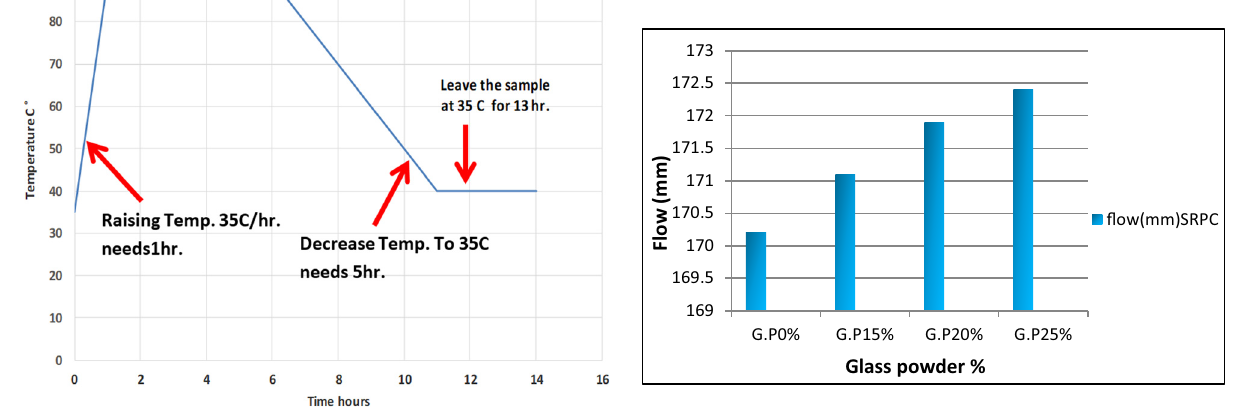
Figure 3: Cycle of steam curing.